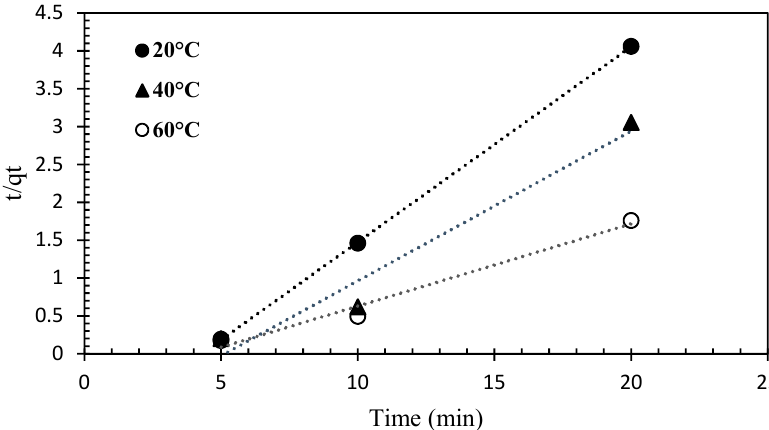
Figure 14. Kinetics of arsenic adsorption at three different temperatures.